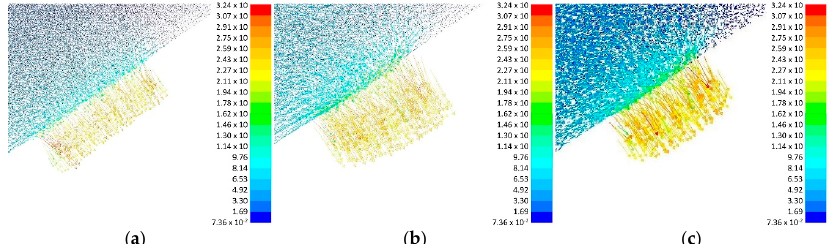
Figure 11. Velocity field for transversal orifice at P = 5.0 bar and Q in = ( a ) 10 L/s, ( b ) 20 L/s, ( c ) 30 L/s.